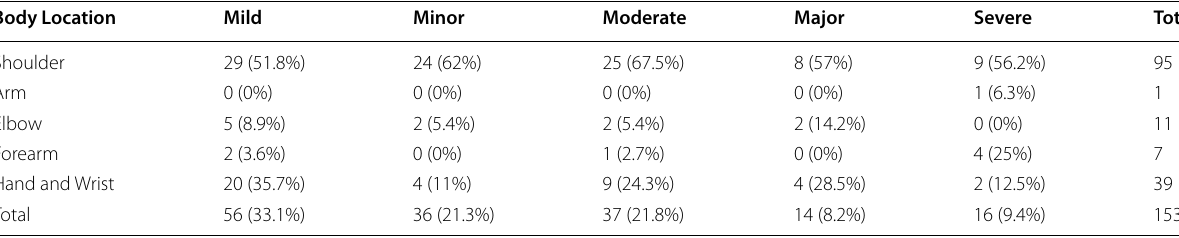
Table 3 Relation between severity of injury and body location Body